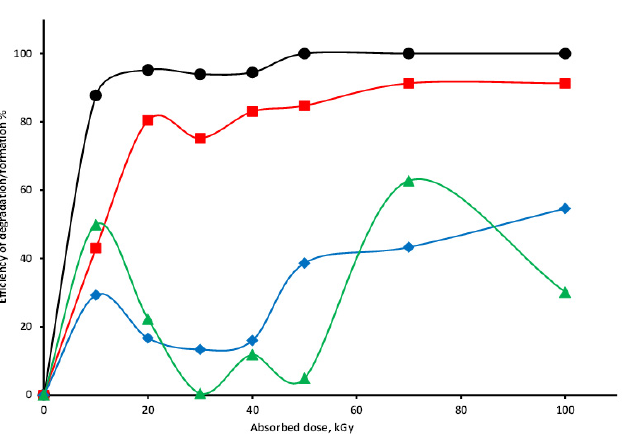
Figure 1. Efficiency of removing ADs from aqueous solution using gamma radiation under different conditions: ( A ) 10 mg/L sertraline, ( B ) 1 mg/L sertraline and ( C ) 10 m/L citalopram, ( D ) 1 mg/L citalopram. Conditions of irradiation: (  ) solution saturated with argon in the presence of t- i.e., 100 µ g/L, the application of UV light achieves practically complete degradation after butanol at pH 7-solvated electrons predominate, ( ● ) solution saturated with N 2 O • OH radicals